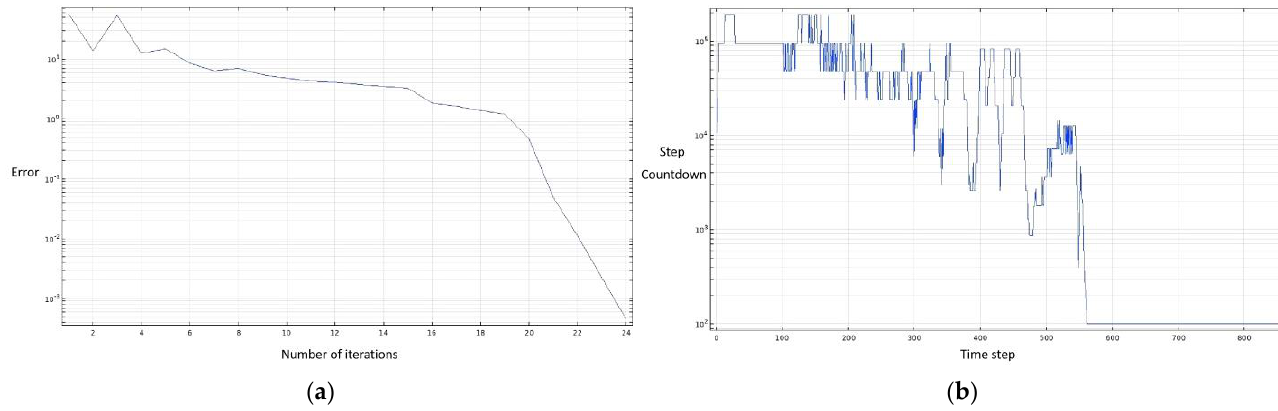
Figure 2. Grid irrelevance verification.